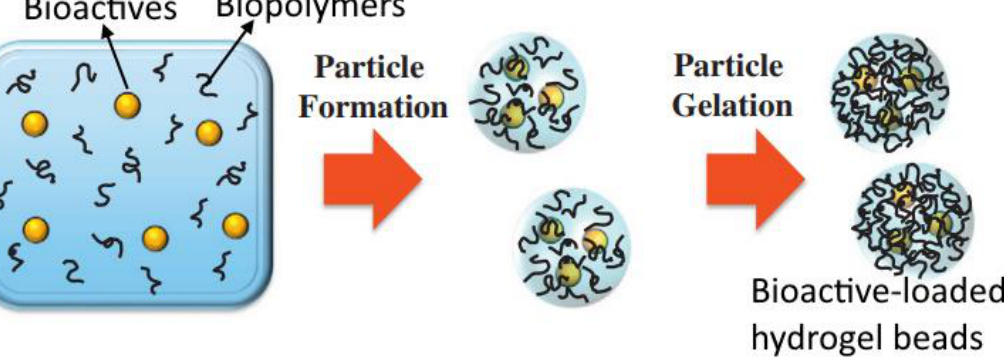
Figure 6. Illustration of a biopolymer-based delivery system for the encapsulation of bioactive compounds. Figure 6 is reprinted with permission from McClements [128] (Copyright © 2016 Elsevier B.V., Amsterdam, The Netherlands). Table 3. Different types of hydrogel-based systems for the encapsulation of bioactive compounds.